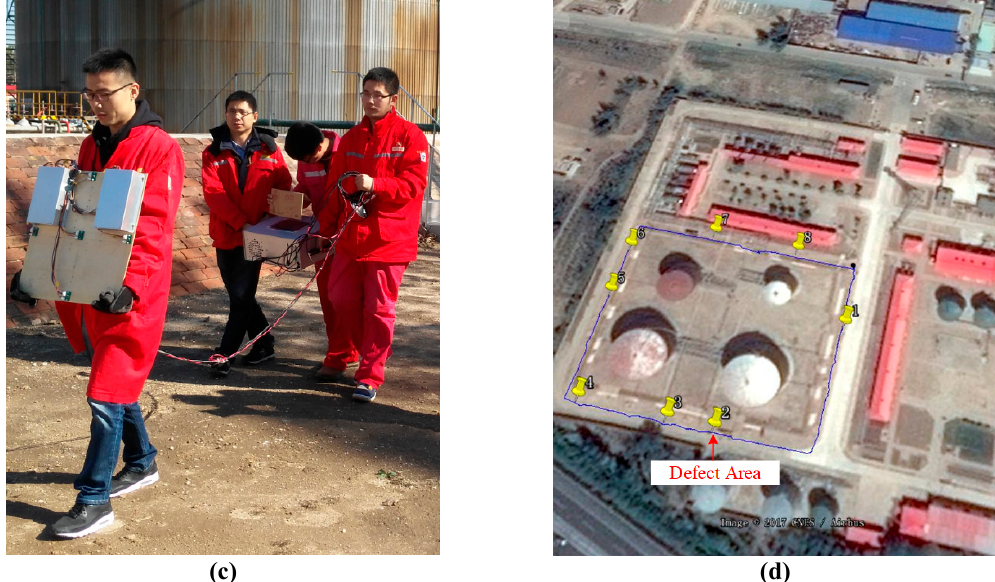
Figure 7. Laboratory experiment of pipeline inspection. ( a ) Picture of experimental setup, 1—Global positioning system, 2—Data Acquisition System, 3—Acquisition Card, 4—Magnetic Sensor; ( b ) Laboratory scheme design; ( c ) Field test; ( d ) Defect location.